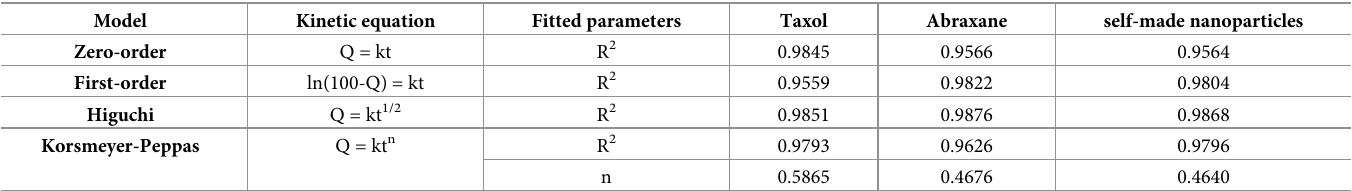
Table 1. Release mechanism of Taxol, Abraxane, and self-made nanoparticles.